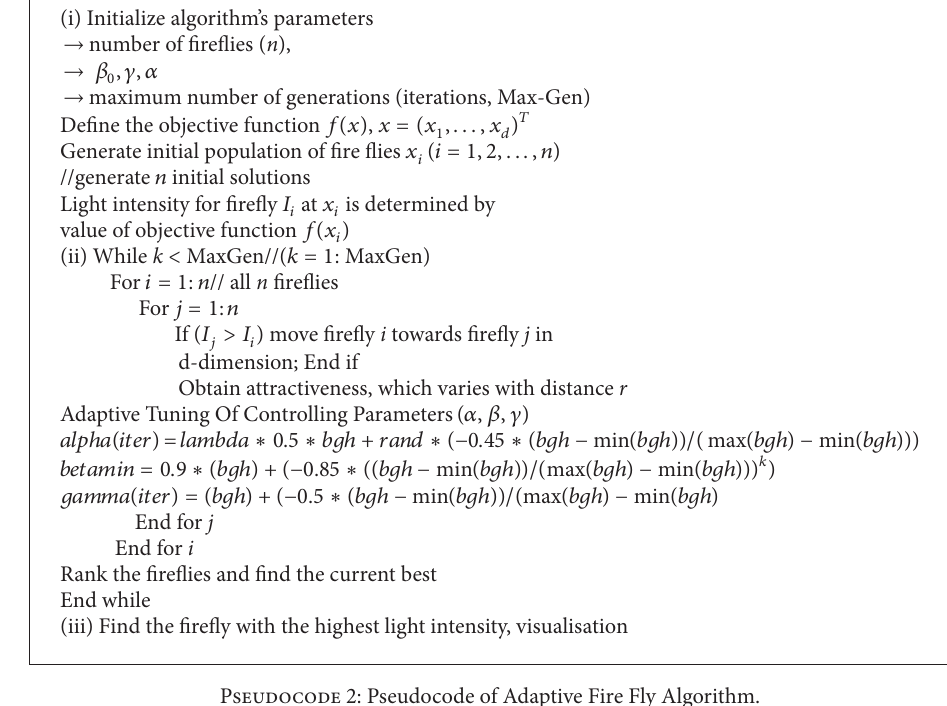
Pseudocode 2: Pseudocode of Adaptive Fire Fly